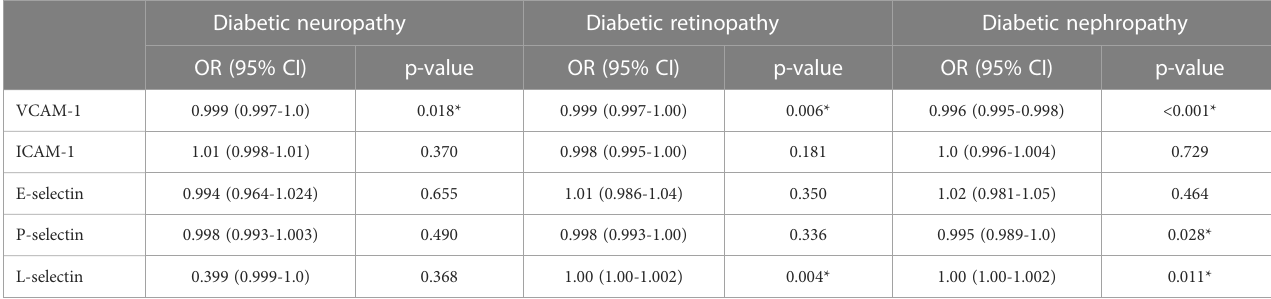
TABLE 4 Binary logistic regression analysis to determine the association between levels of cell adhesion molecules and selectins with microvascular complications in patients with type 2 diabetes mellitus. Diabetic neuropathy Diabetic